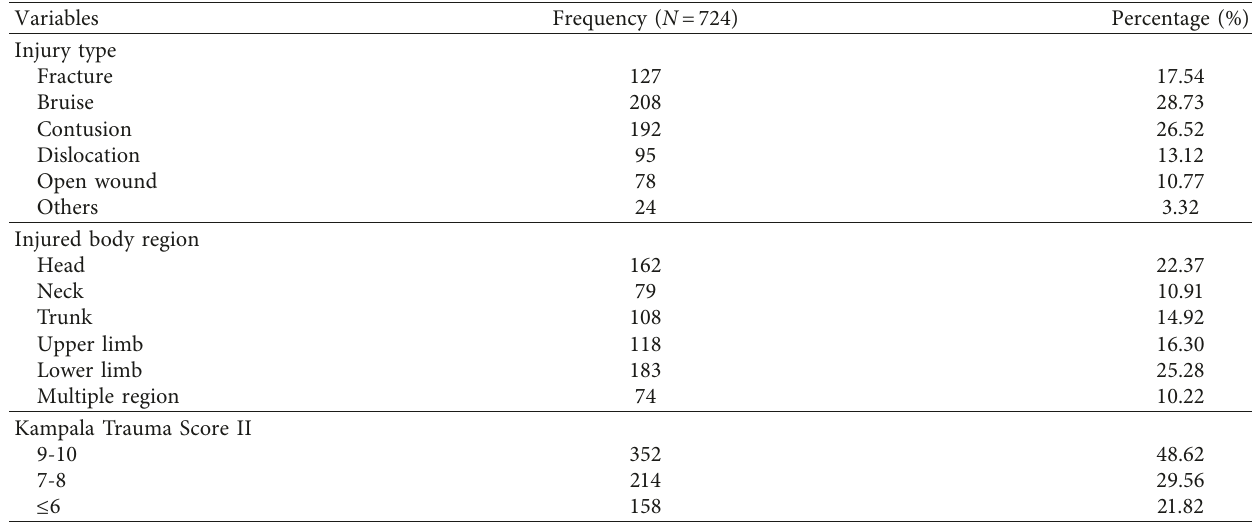
Table 3: Characteristics of shared bicycle-related